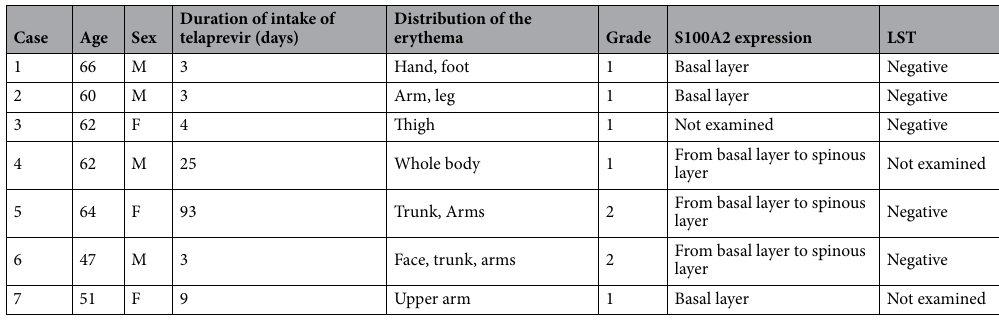
Table 1. Summary of the patients with adverse skin reactions by